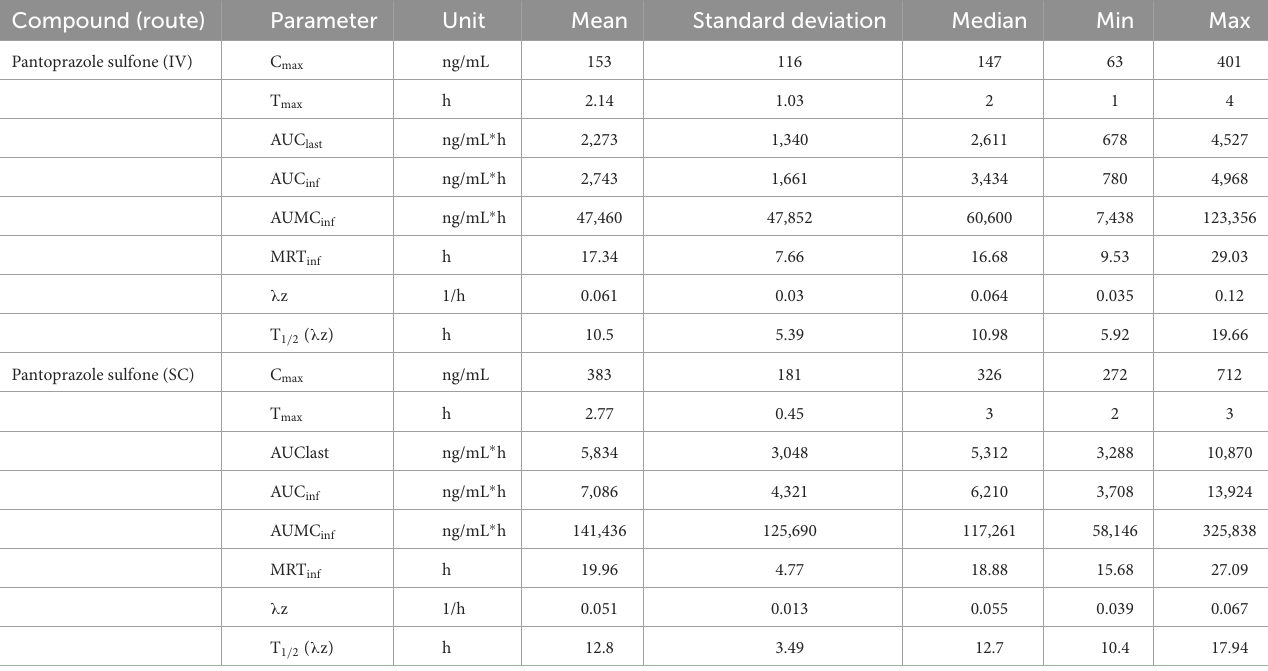
TABLE 4 Day 3 pharmacokinetic parameters of pantoprazole sulfone after intravenous (IV) and subcutaneous (SC) administration of pantoprazole sodium in calves. Compound (route) Parameter Pantoprazole sulfone